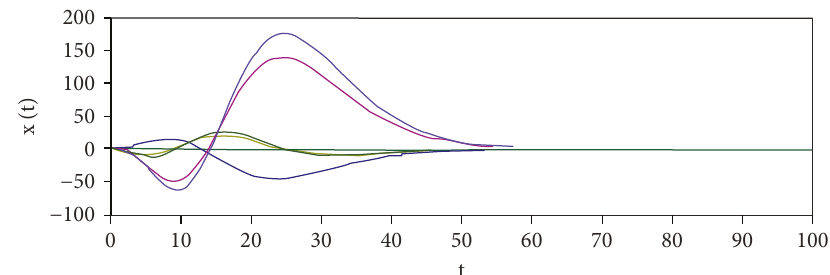
Figure 3: Stabilization via harmonic control.